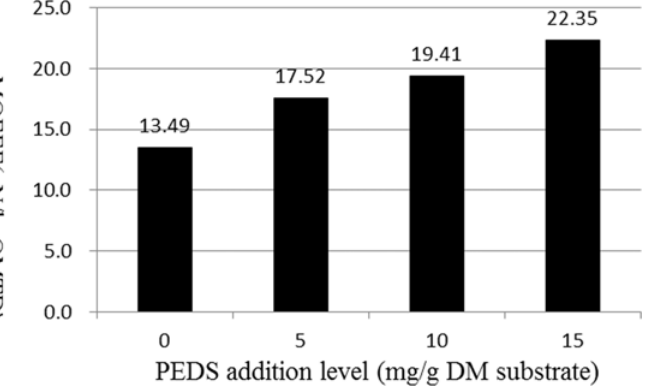
Fig 1. The microbial efficiency affected by the addition level of PEDS in continuous culture. (A) The addition level of PEDS was 0 (control), 5, 10 and 15 mg/g DM substrate. (B) MOEEF (microbial efficiency) was expressed as g of microbial nitrogen per kg of OM truly digested